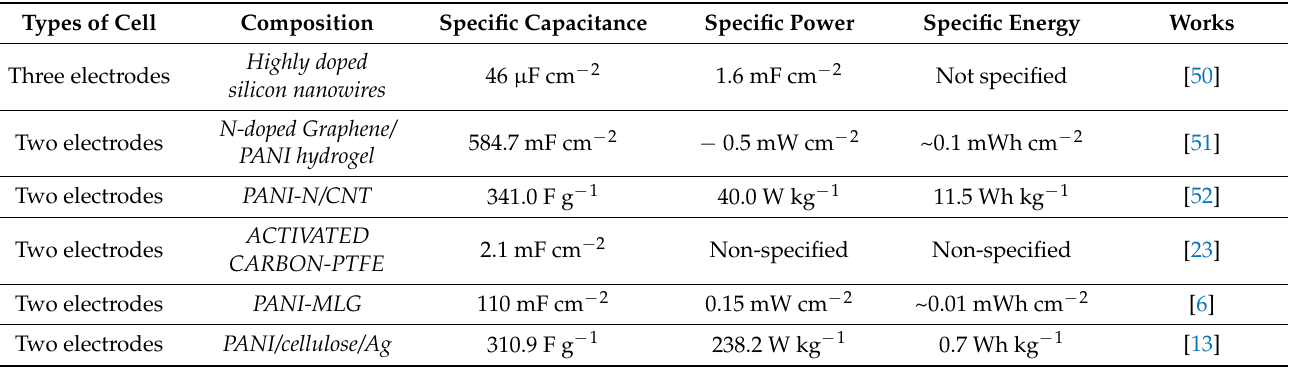
Table 3. Comparison between this work and others present in literature for supercapacitor